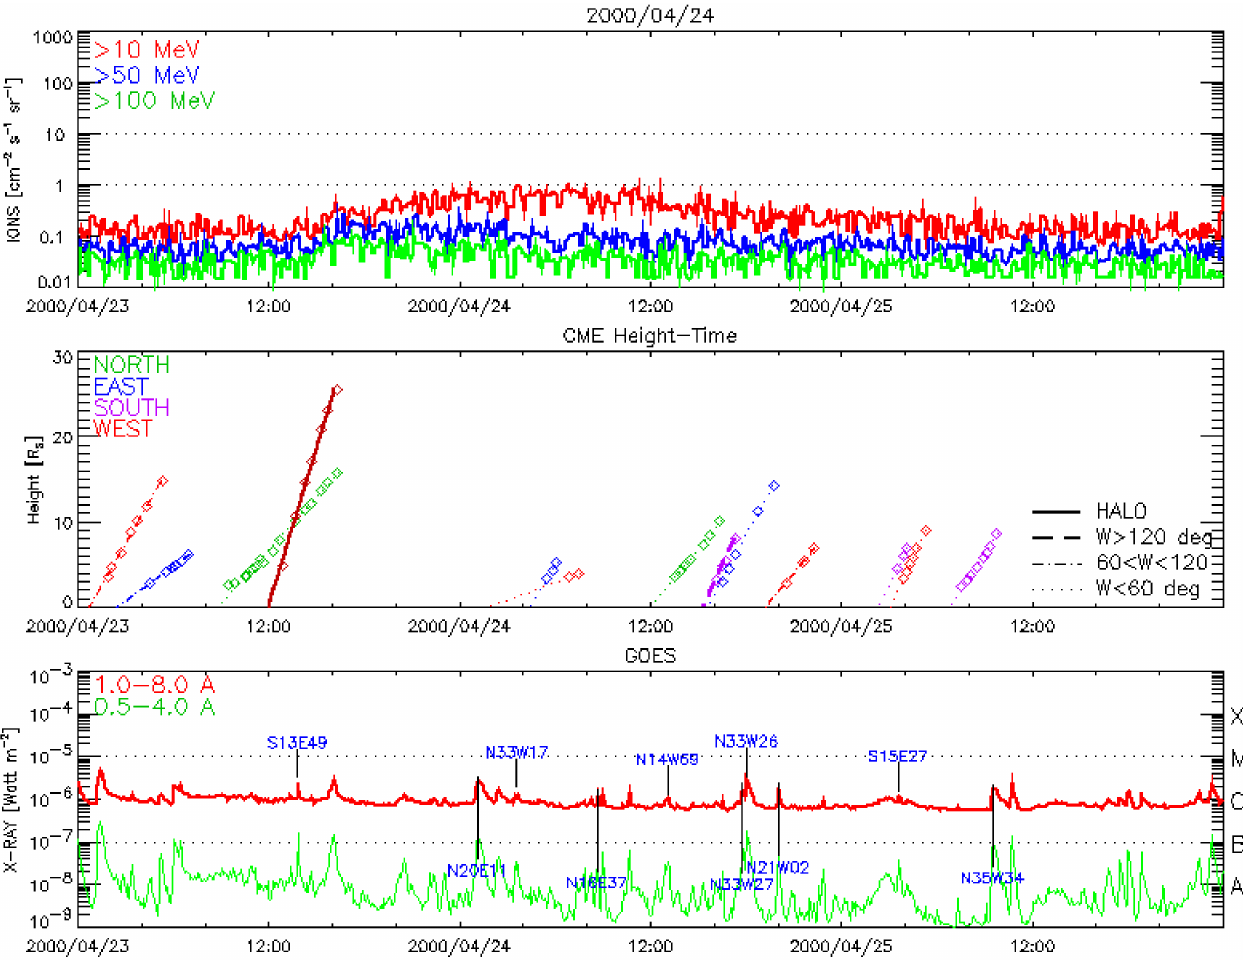
Fig. 8. (top) GOES SEP intensity in three channels (red: > 10MeV, blue: > 50MeV, and green: > 100MeV) along with CME height-time plot and GOES soft X-ray plot for the 23 April 2000 RQ CME. (middle) CME height-time plots, the solid line indicating full halo CMEs, as noted. The CME of interest is the only halo in the time range plotted. (bottom) The flare locations (heliographic coordinates) are marked, but there is no flare location for the CME in question because it occurred behind the